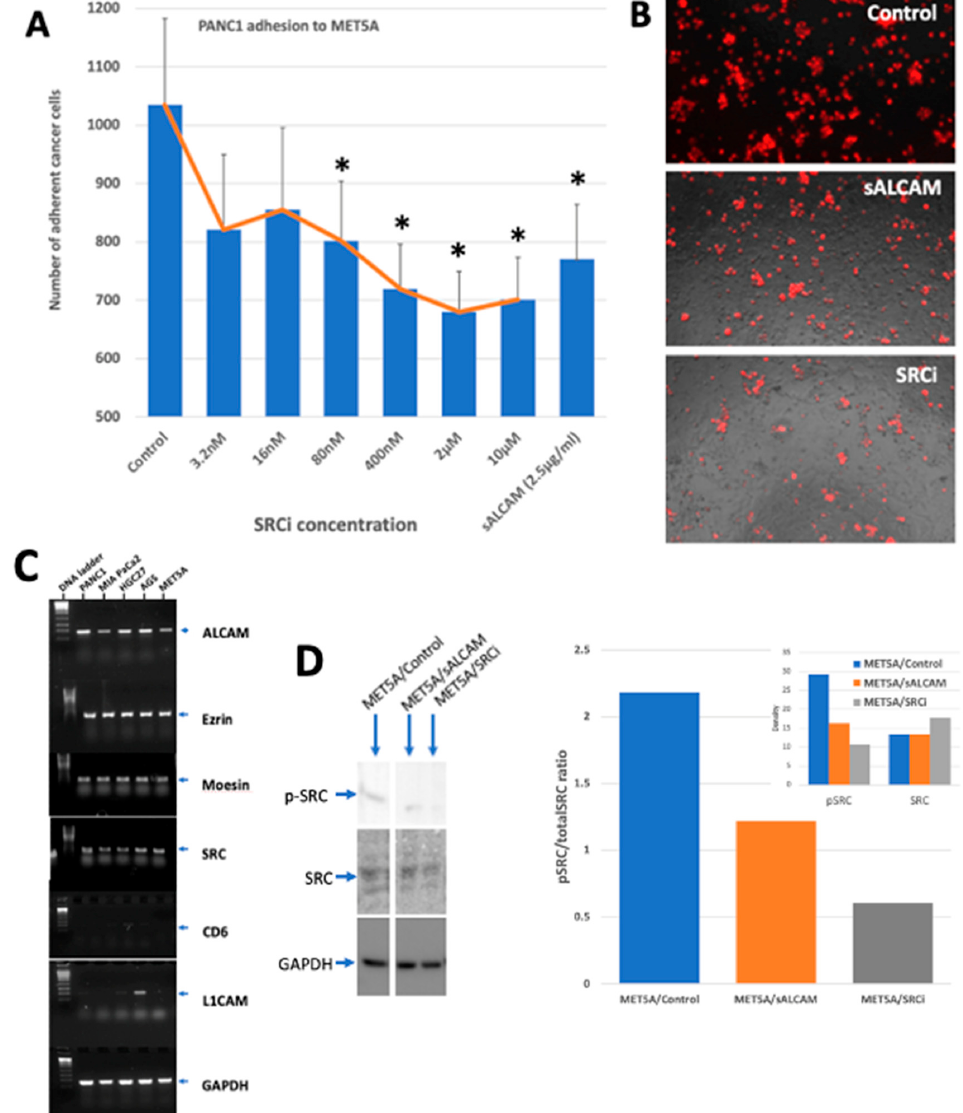
Figure 11. Tumour-mesothelial interaction and the role of SRC kinase. ( A ). The effects of SRC inhibitor (SRCi), AZM475271 on the interaction between pancreatic cancer cell MIA PaCa-2 and mesothelial cells by DiI assay. The SRC inhibitor suppressed the adhesion between 80 nM to 10 µ M, to a degree similar to that of soluble ALCAM (* p < 0.05 versus control). ( B ). Representative